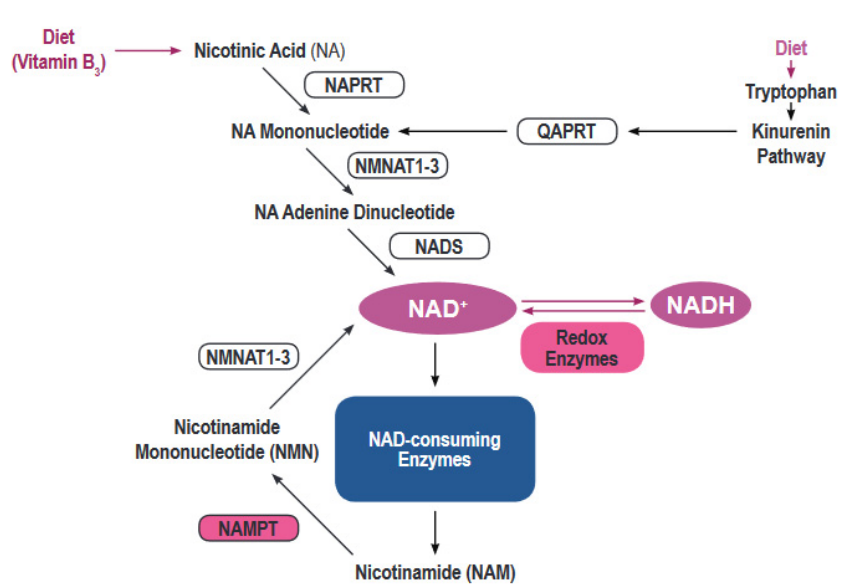
Figure 1. Regulation of the nicotinamide adenine dinucleotide (NAD) metabolism. The figure shows the main synthesis pathways of NAD including the de novo synthesis via the kynurenine pathway or from nicotinic acid and the salvage pathways.